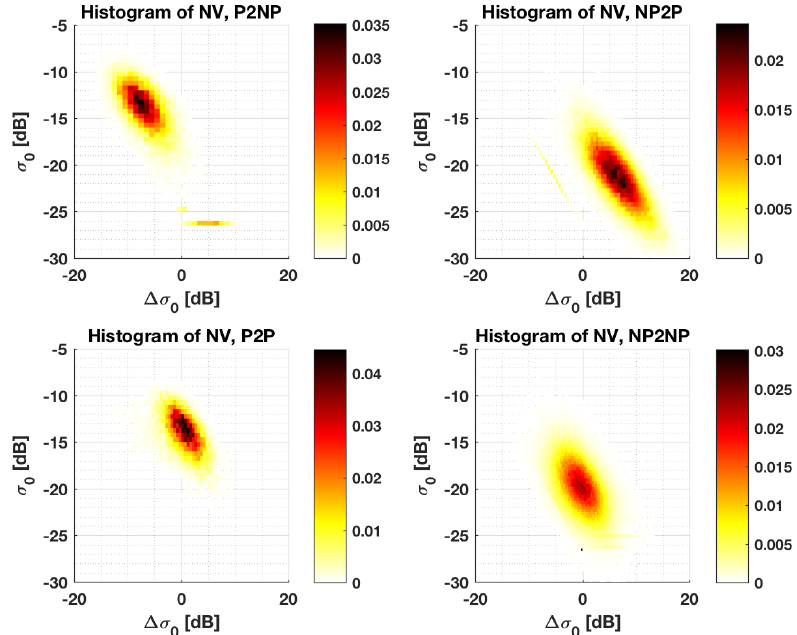
Figure 3. Bivariate histograms for NV per precipitation condition pair. The histograms are